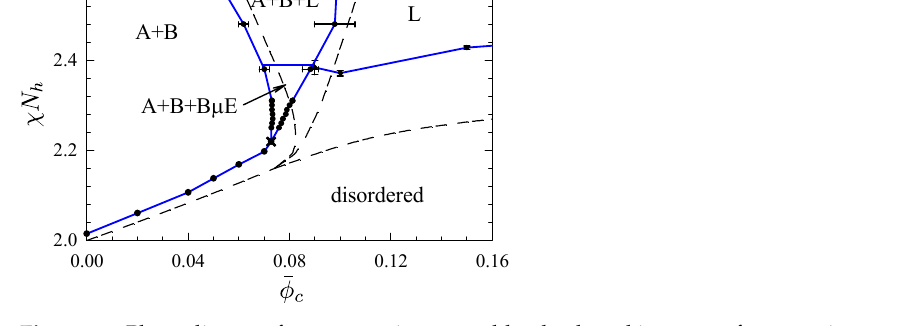
Figure 10. Phase diagram for symmetric ternary blends plotted in terms of segregation strength, χ N h , and copolymer content, ¯ φ c . The labels A, B, L and B µ E denote A-homopolymer rich, B-homopolymer rich, lamellar, and bicontinuous microemulsion, respectively. The cross marks the position of a tricritical point, and the dashed curves compare the SCFT phase diagram [38]. Adapted from Ref.